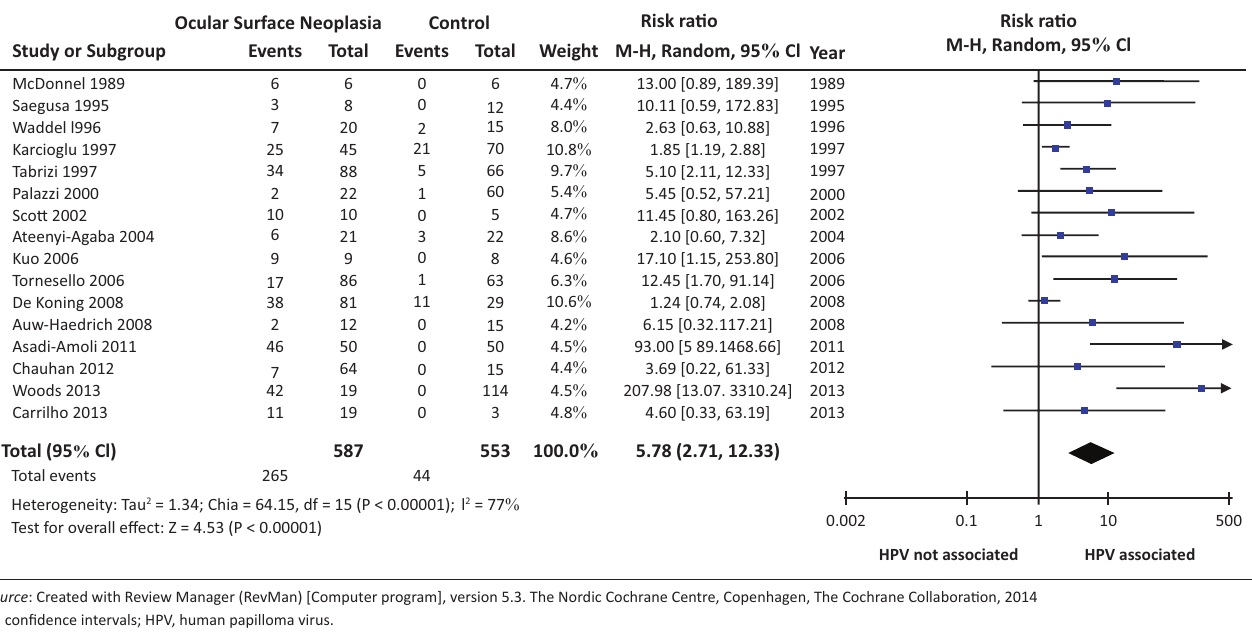
FIGURE 2: Forest plot showing the risk ratio of mucosal and cutaneous human papilloma virus as an association with ocular surface squamous neoplasia. The overall risk ratio was 5.78 and 95 % confidence interval: 2.71–12.33, with high heterogeneity of